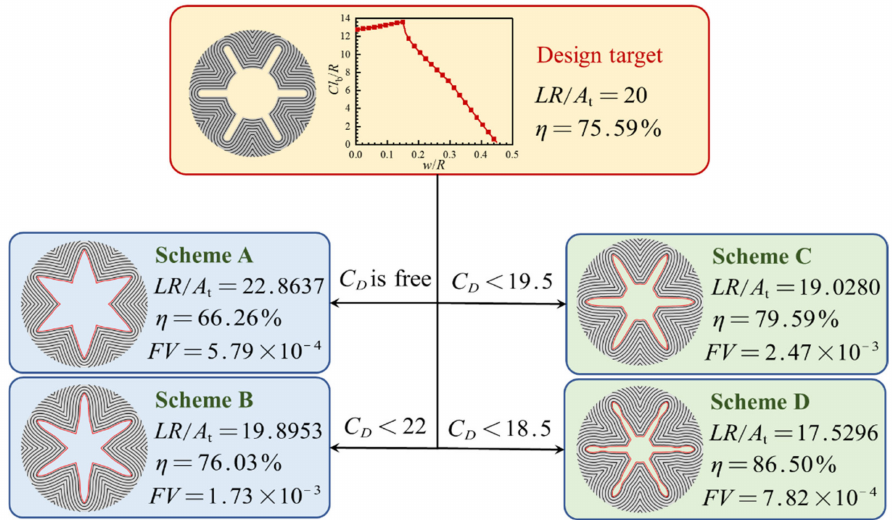
Figure 23. Different schemes sharing identical burning surface areas.